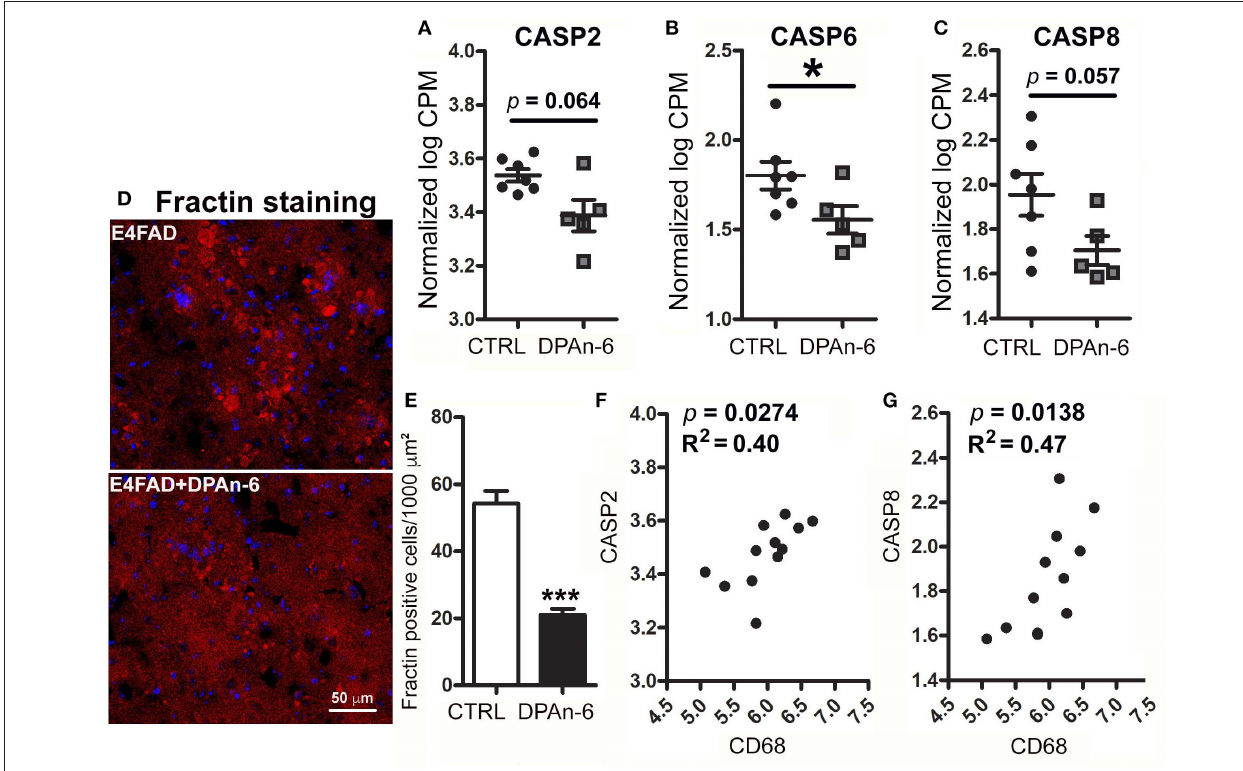
FIGURE 4 | DPAn-6 reduced apoptosis in aged E4FAD mice. In RNA-Seq data, (A–C) DPAn-6 reduced gene expression of caspase 2 (CASP2, a trend p = 0.064, (A) ), caspase 6 (CASP6, p < 0.05, (B) ), and caspase 8 (CASP8, a trend p = 0.057, (C) ) compared to controls (CTRL) on standard diet (ST). (D,E) Immunofluorescence staining revealed that DPAn-6 reduced caspase-cleaved fragment of actin (Fractin (red), D ; p < 0.001, E ). Nuclei were stained by DAPI (blue). (F,G) Activated microglial marker CD68 was positively correlated with CASP2 ( p = 0.0274, R 2 = 0.40, (F) ) and CASP8 ( p = 0.0138, R 2 = 0.47, (G) ). The RNA-Seq data were normalized by Counts Per Million (CPM) and presented as Log2 expression. Data represent the mean ± SEM. Significance was determined using an unpaired, two-tailed Student’s t -test, * p < 0.05, and *** p < 0.001.